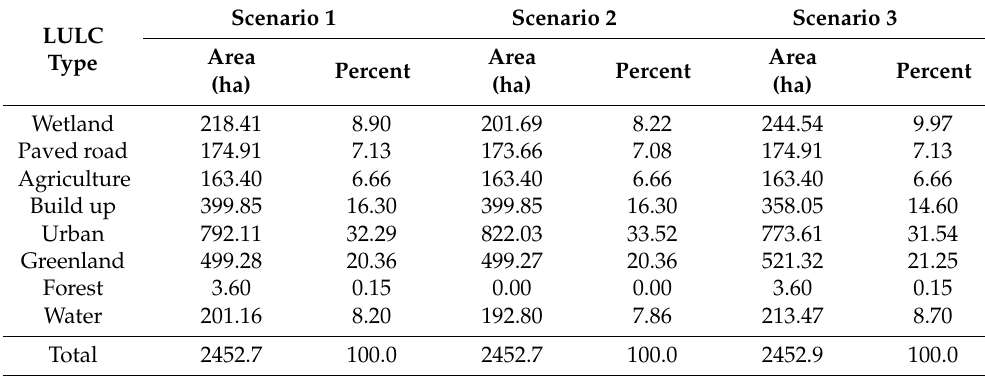
Table 2. The percentage of Qunli Park about LULC data in the three scenarios.